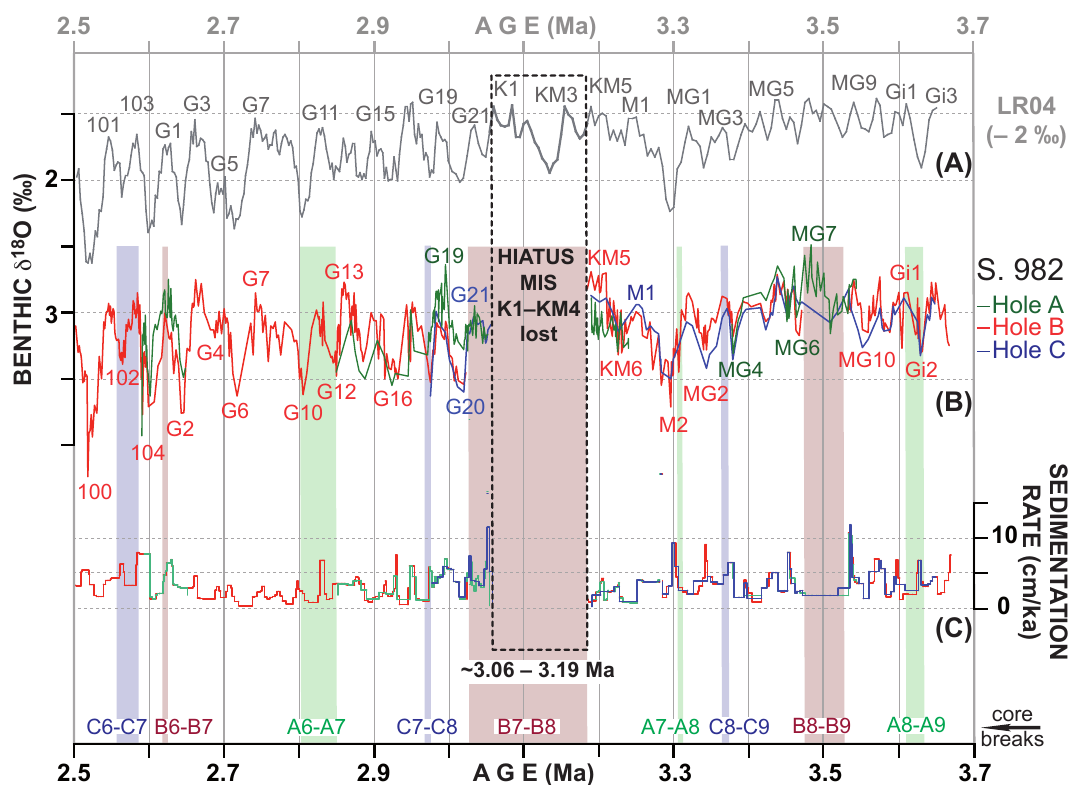
Fig. 2. (B) New marine-isotope stage chronology for δ 18 O records of ODP holes 982A, B, and C versus age (data from Venz and Hodell, 2002, Lisiecki and Raymo, 2005, and this study, as specified in Table S1) vs. (A) δ 18 O record of global ice volume LR04 (Lisiecki and Raymo, 2005) and (C) sedimentation rate